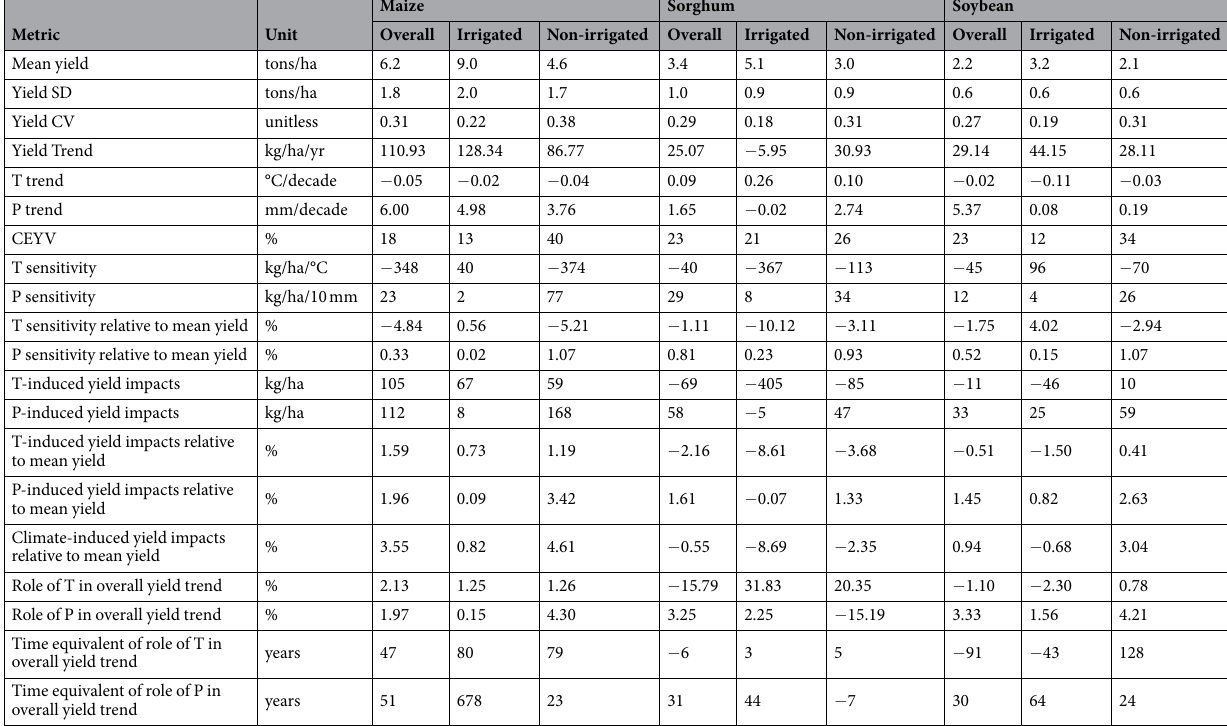
Table 1. Regional magnitudes of the metrics employed in the study for all three